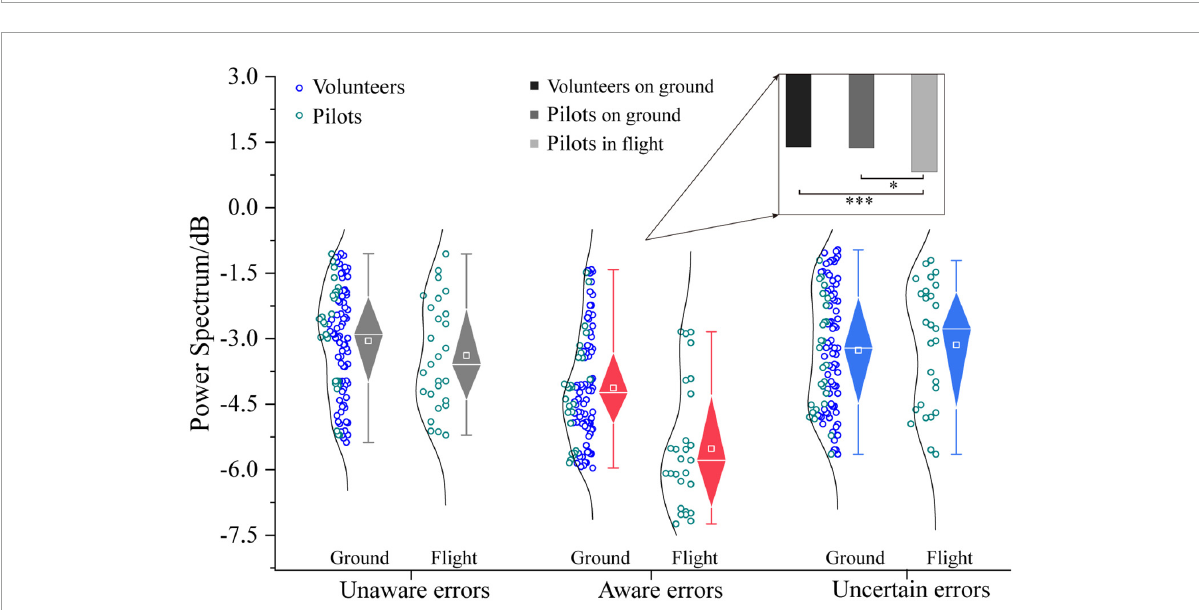
FIGURE9 Differences in α -frequency band between pilots and volunteers in multiple error awareness on the ground or in flight environment. The squares in the box plots indicated the mean values, the white horizontal lines indicated the medians, and both ends indicated the maximum and minimum values ( ∗ p < 0.05, ∗∗∗ p <